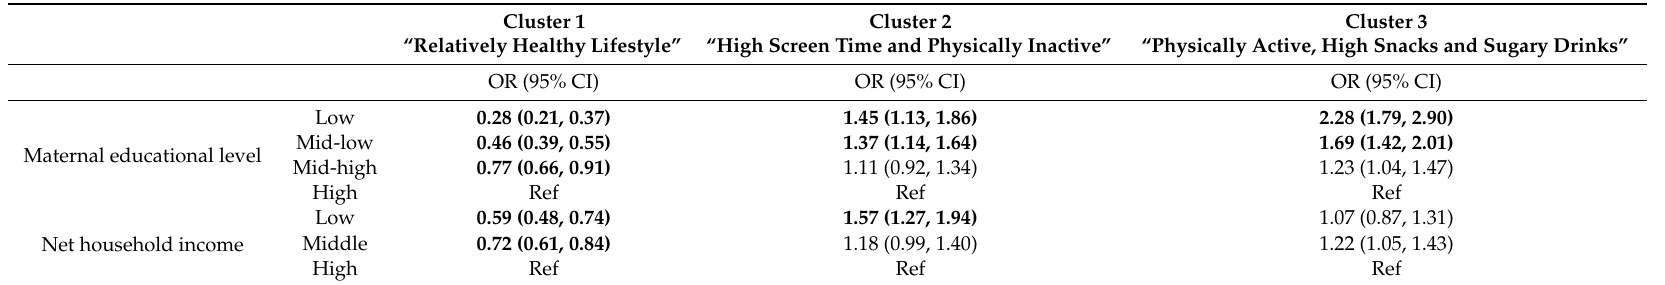
Table 4. The association of socioeconomic status with child lifestyle clusters at age